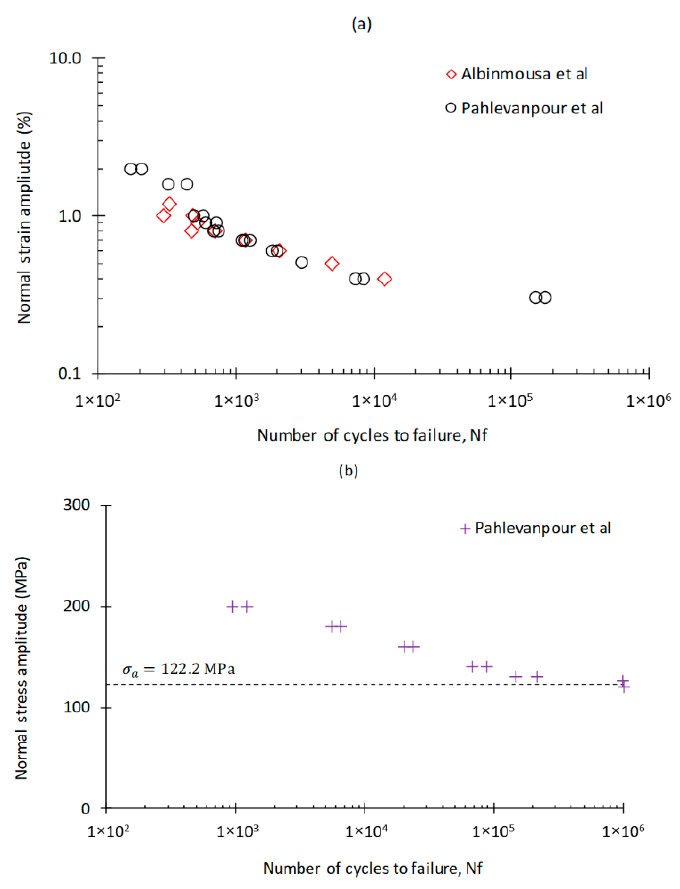
Figure 3. Cyclic behavior of ZK60 extrusion. ( a ) Normal strain–life curves [36], reproduced from [36], with permission from Elsevier, 2020. and ( b ) stress–life curve [34], reproduced from [34], with permission from Elsevier, 2020.